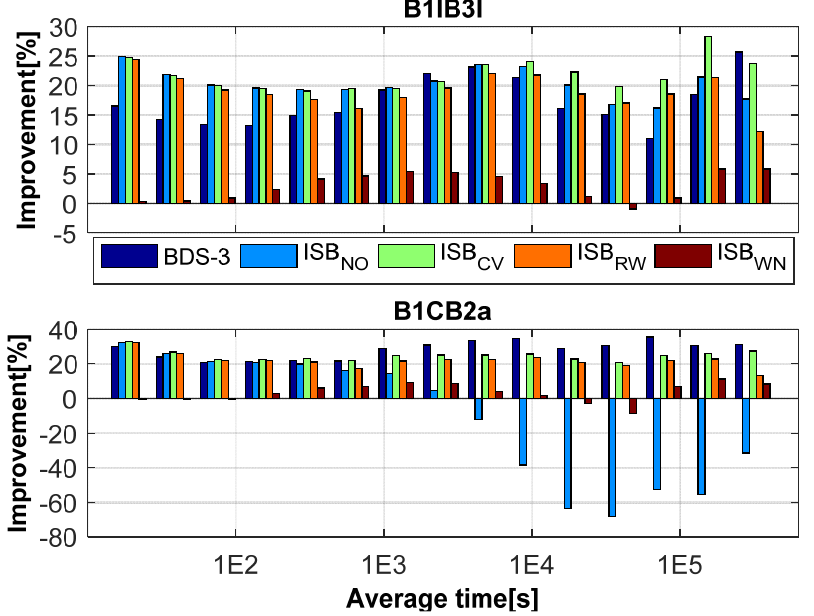
Figure 17. Percentage improvement in ADEV of BDS-3-only and BDS (BDS-2/BDS-3 using four ISB stochastic models) solutions compared BDS-2-only.